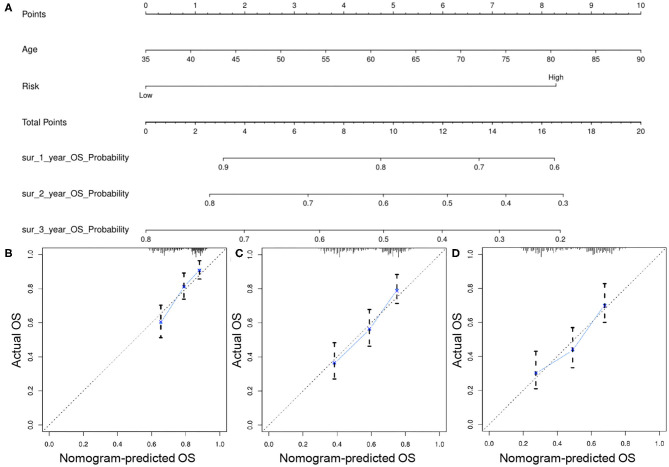
Nomogram considering glycolysis and clinical factors for prediction of the individualized survival probability of GC patients. (A) Development of a nomogram containing age and risk score to predict 1-, 2-, and 3-year OS. (B–D) Calibration plots of the nomograms in terms of the agreement between nomogram-predicted and observed 1-, 2-, and 3-year survival outcomes of the GC cohort. The 45° dashed line represents the ideal performance. The actual performances of the model are represented by the blue lines, and the figures from left to right illustrate the 1-, 2-, and 3-year results, respectively.